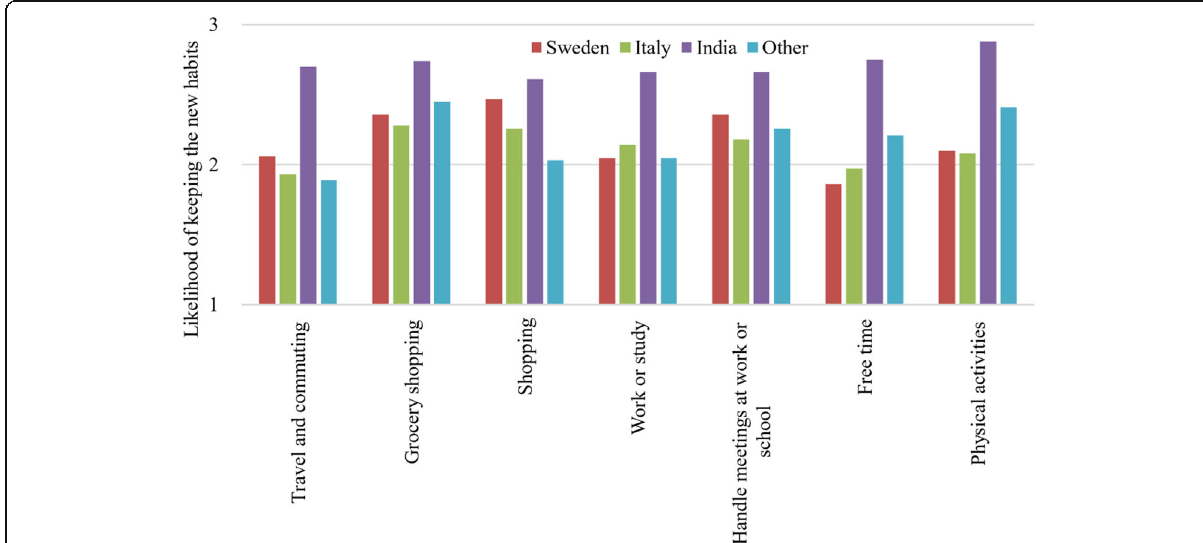
Fig. 6 The respondents average reported likelihood of keeping their new habits in the different activities, from 1 (not likely) to 4 (very